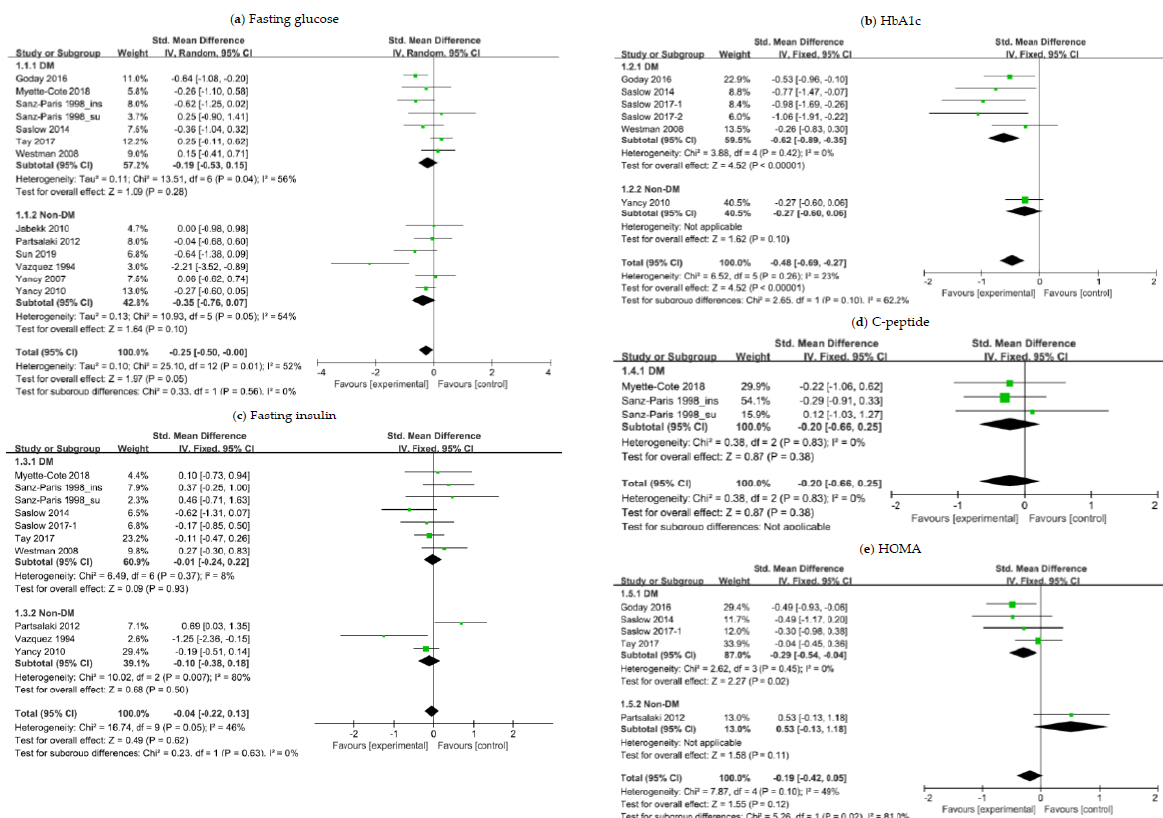
Figure 3. Forest plots for association between glycemic control and ketogenic diet in patients with overweight or obesity and with or without T2DM: ( a ) Changes in fasting glucose; ( b ) changes in HbA1c; ( c ) changes in fasting insulin; ( d ) changes in C-peptide; ( e ) changes in HOMA. Abbreviations: CI, confidence interval; DM, diabetes mellitus; Non-DM, non-diabetes mellitus; HbA1c, glycated hemoglobin; HOMA, homeostatic model assessment; T2DM, type 2 diabetes mellitus.